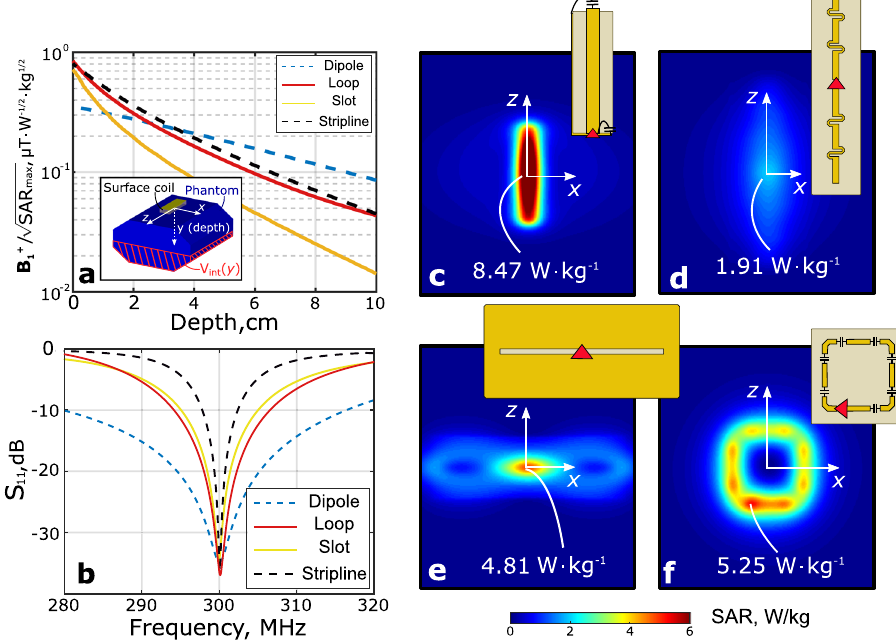
ffiffiffiffiffiffiffiffiffi p = SAR factor for different 1